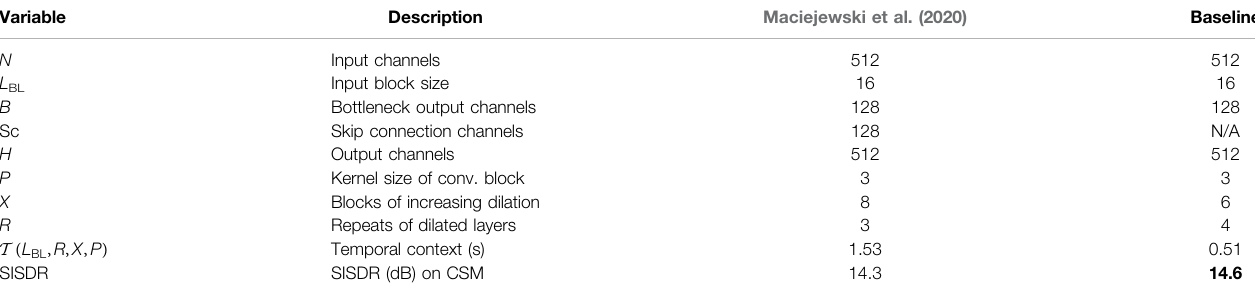
TABLE 2 | Details of the Conv-TasNet con fi guration compared to Maciejewski et al. (2020). Bold indicates SISDR result of the proposed baseline.